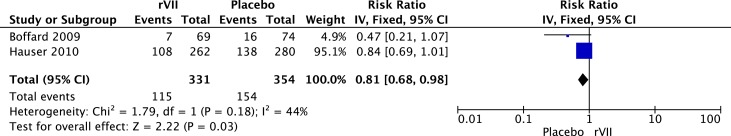
Meta-analysis: the effect of administration of rVII on the development of MOF. A significant lower incidence of MOF was observed in patients with rVII compared to patients with placebo (P = 0.03).